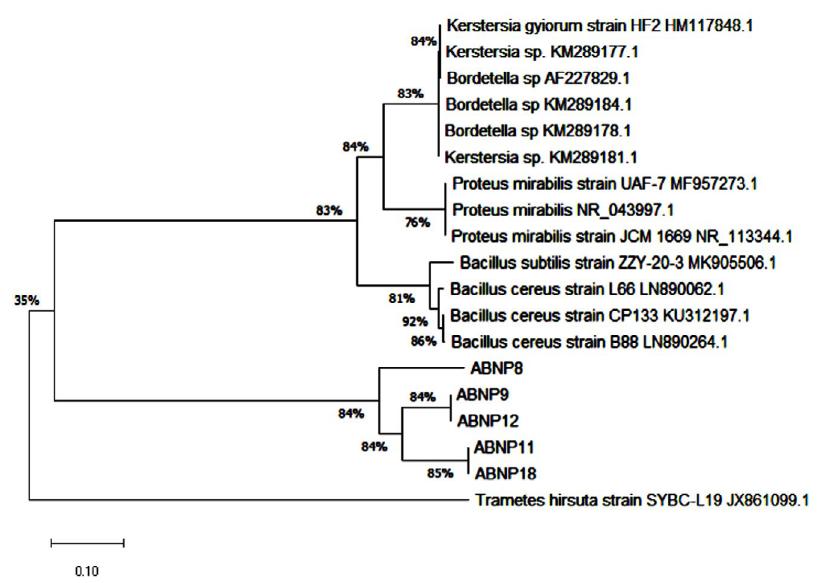
Fig. 4. Phylogenetic tree B. thuringiensis local isolate Auky Island Padaido District in Biak Numfor Papua